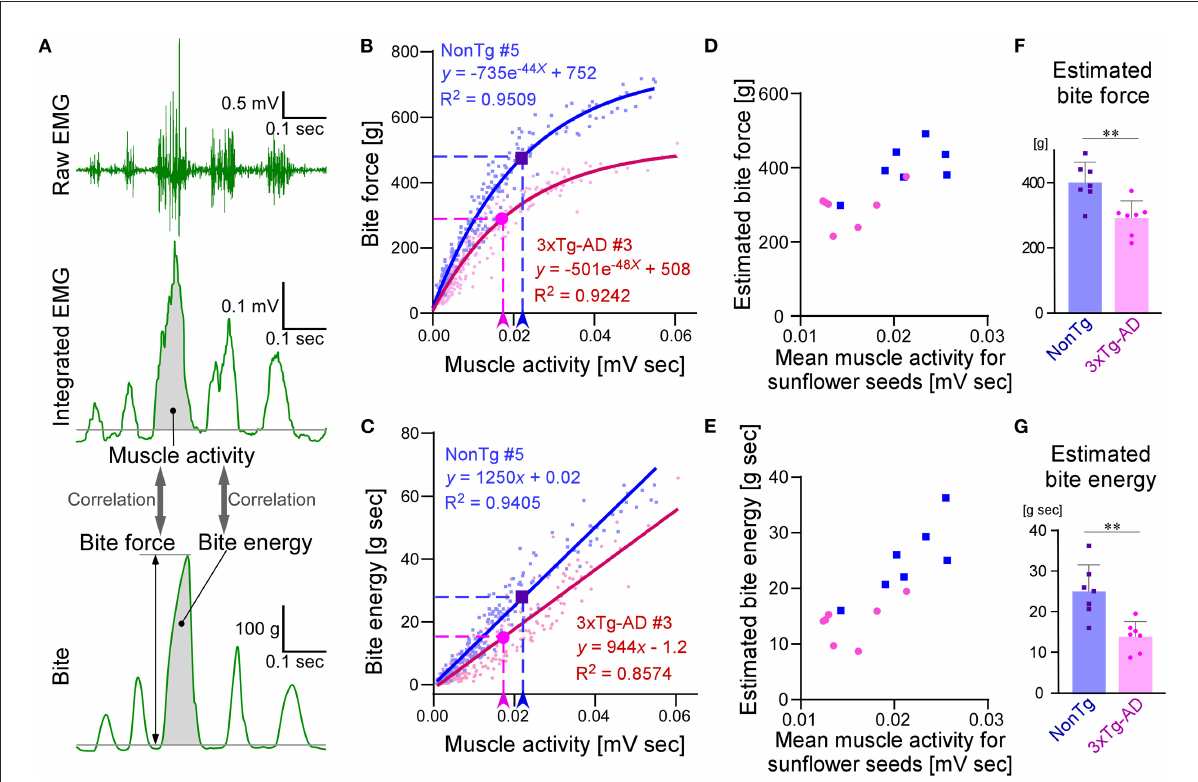
FIGURE6 Estimation and comparison of bite force and bite energy during sunflower seed feeding between 3–4-month-old NonTg and 3 × Tg-AD mice by CLEF analysis. Representative waveforms of raw EMG findings in the masseter muscle, integrated EMG, and bite when mice chewed bite bars (A) . CLEF analysis between muscle activity and bite force or energy was performed on 14 mice, seven each of NonTg and 3 × Tg-AD mice. Scatter plot and nonlinear regression curves showing the correlation between muscle activity and bite force when NonTg mouse #5 ( B ; blue dots and solid curve) and 3 × Tg-AD mouse #3 ( B ; red dots and solid curve) chewed bite bars. Arrowheads and dotted lines indicate the mean value of muscle activity when eating sunflower seeds and the biting force estimated from it, respectively (B) . Scatter plot and linear regression lines showing the correlation between muscle activity and bite energy when NonTg mouse #5 ( C ; blue dots and solid curve) and 3 × Tg-AD mouse #3 ( C ; red dots and solid curve) chewed bite bars. Arrowheads and dotted lines indicate the mean value of muscle activity when eating sunflower seeds and the biting energy estimated from it, respectively (C) . Scatter plots and nonlinear regression curves or linear regression lines for the other 12 mice, not shown here, are provided in Supplementary Figure S2. Scatter plots of mean muscle activity while chewing sunflower seeds and estimated bite force (D) or energy (E) in NonTg (blue dots) and 3 × Tg-AD (red dots) mice, seven mice each. 3 × Tg-AD mice had significantly lower estimated bite force ( F ; ** p = 0.0038, two-tailed unpaired t -test) and energy ( G ; ** p = 0.0020, two-tailed unpaired t -test) during sunflower seed chewing, compared with NonTg